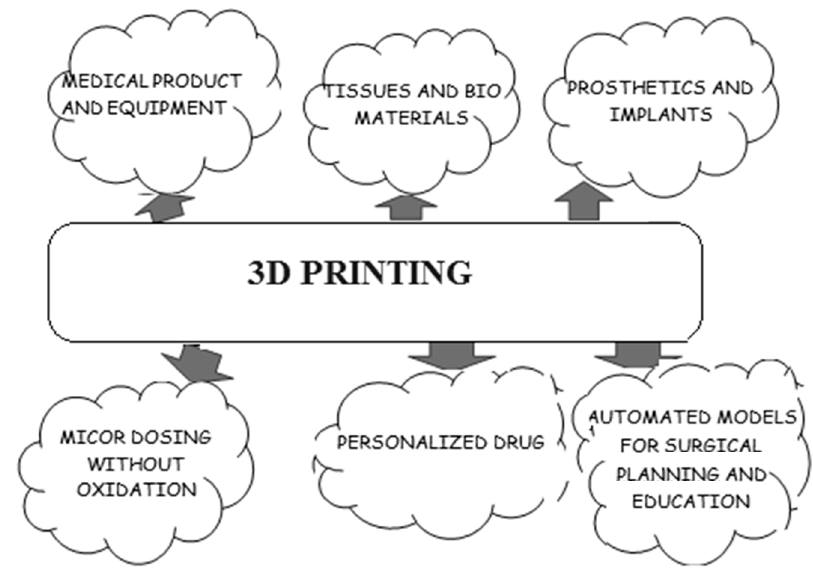
Figure 4. 3D-printing and its applications .